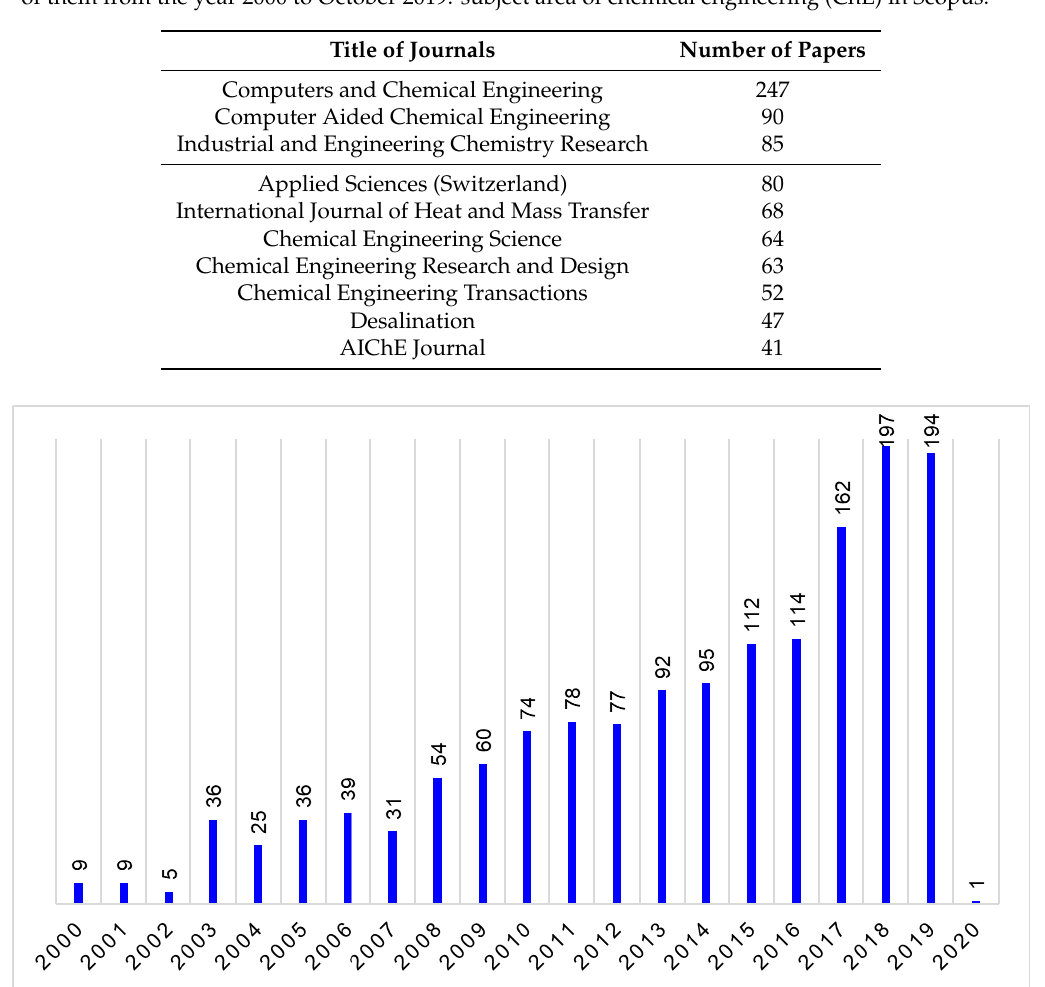
Table 2. Titles of journals (which published at least 40 relevant papers) and number of papers in each of them from the year 2000 to October 2019: subject area of chemical engineering (ChE) in Scopus.